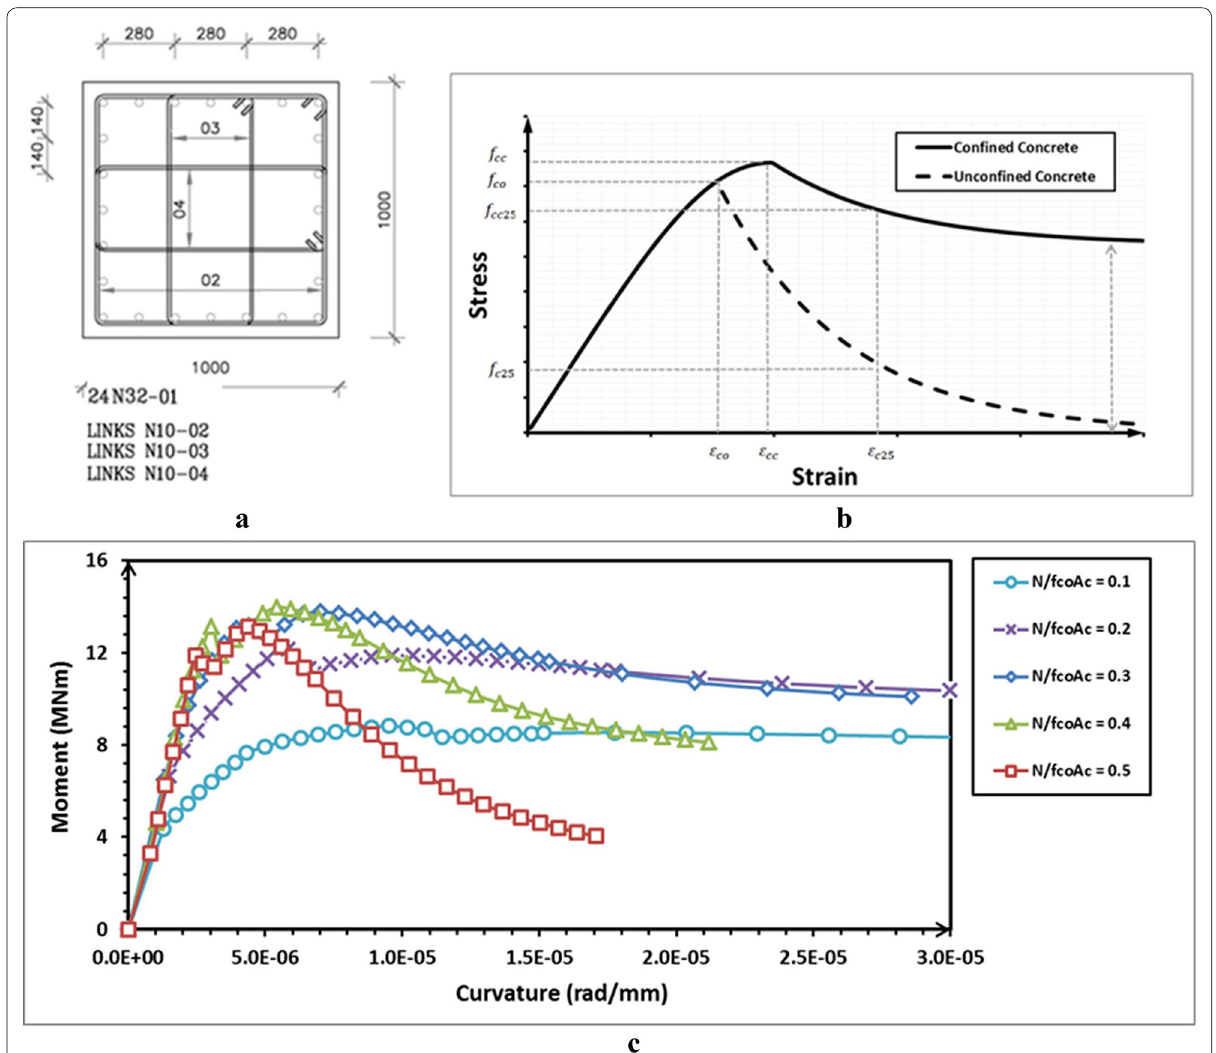
Fig. 3 Moment–curvature analysis: a Geometry of the column, b stress–strain relationship for confined and unconfined concrete, c nonlinear moment–curvature behaviour for different axial load levels ρ l